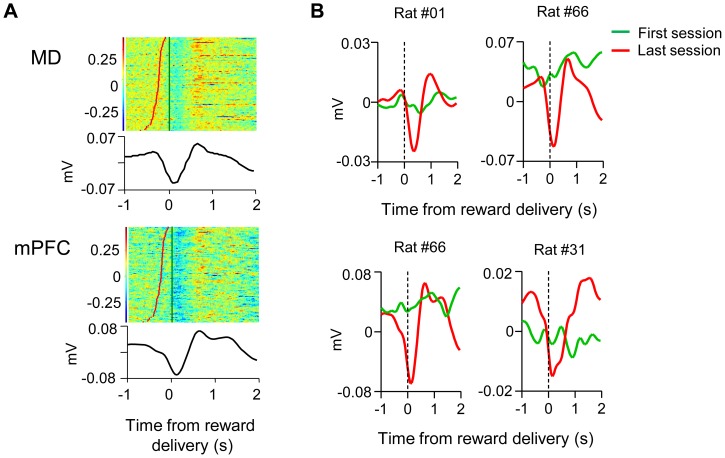
Learning-related modulation in LFP activities.
A, Perievent raster plots of representative LFP recording. Both examples display depolarization following reward delivery. B, Perivent histograms of representative LFP recorded from 3 rats during the first training session and the last session (top, MD; bottom, mPFC). LFPs exhibit depolarization (negativity in the extracellular recording) with learning.